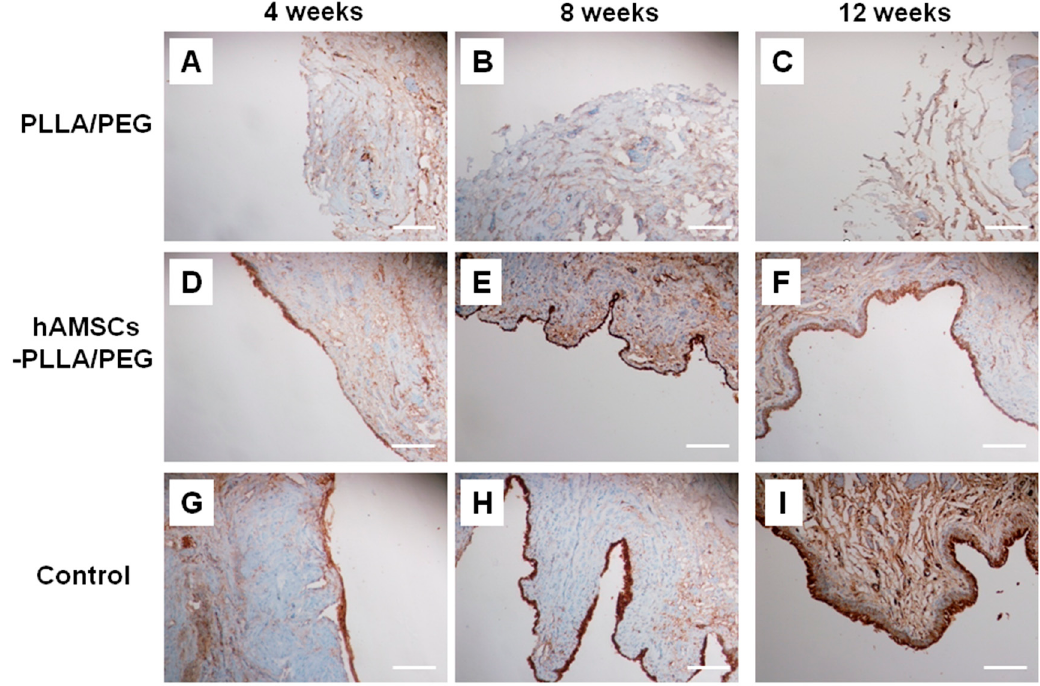
Figure 7. Immunohistochemical evaluation of urethral tissues by AE1/AE3 staining at 4, 8, and 12 weeks post-operation. ( A – C ) implanted with PLLA/PEG scaffolds; ( D – F ) implanted with hAMSCs–PLLA/PEG constructs; ( G – I ) given mock operation. Scale bars, 100 μ m.